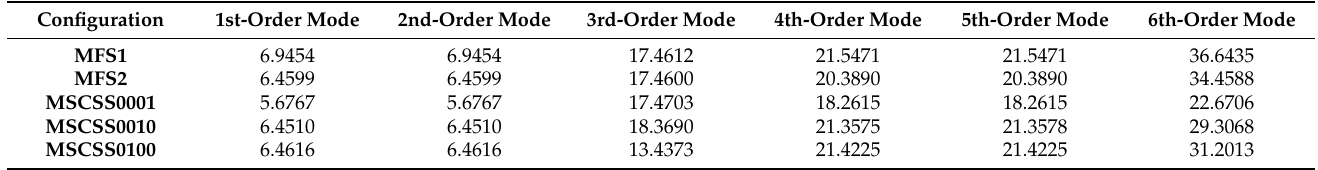
Table 3. The theoretical frequencies (Hz) of investigated configurations.